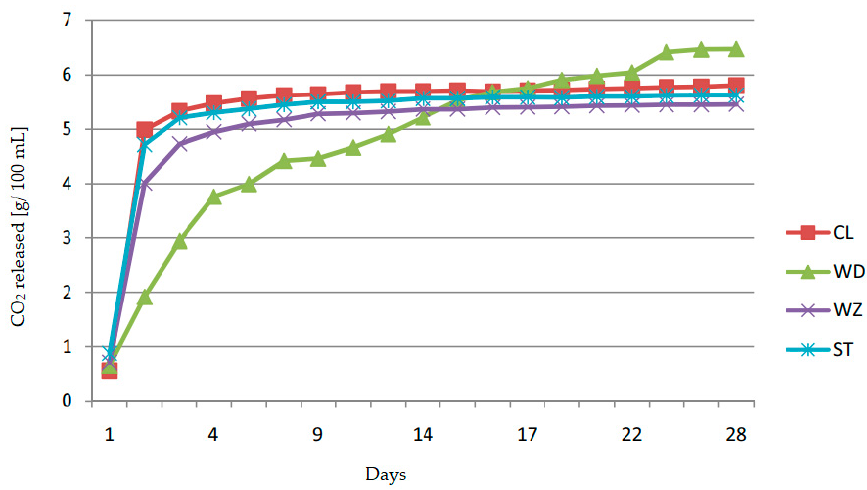
Figure 3. Fermentation dynamics of plum must fermented with H. uvarum H2, n = 5, STD < 5%. Abbreviations: CL— Č a č anska Lepotica, WD—W ę gierka D ą browicka, WZ—W ę gierka Zwyk ł a, ST—Stanley.